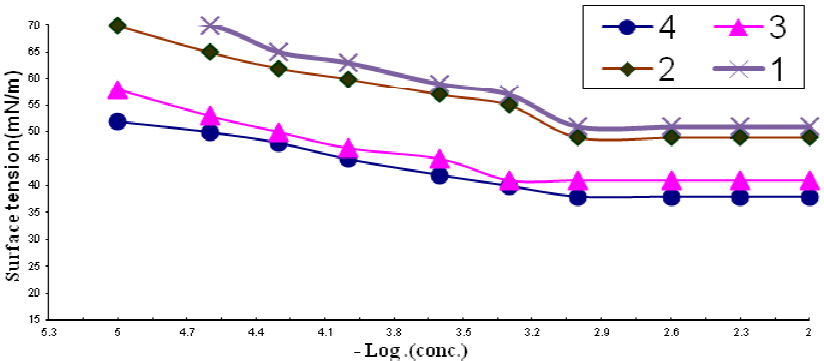
Figure 2. Variation in surface tension of surfactants 1 – 4 vs . concentration at 25 °C concentration, expressed as mol/L.